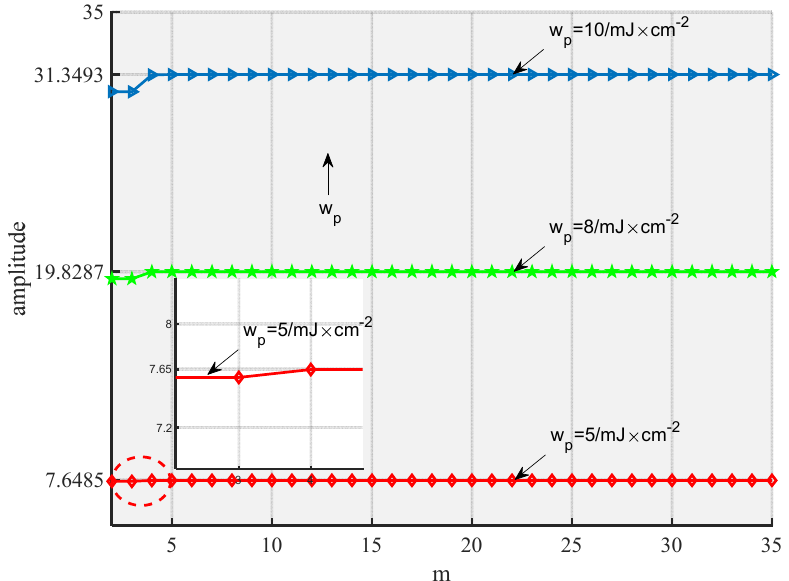
Figure 8. The variation in the second harmonic amplitude with number of iterations for different light energies.